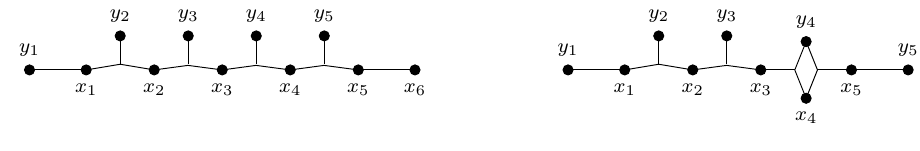
Fig. 1: A winning path (left) and a losing path (right).